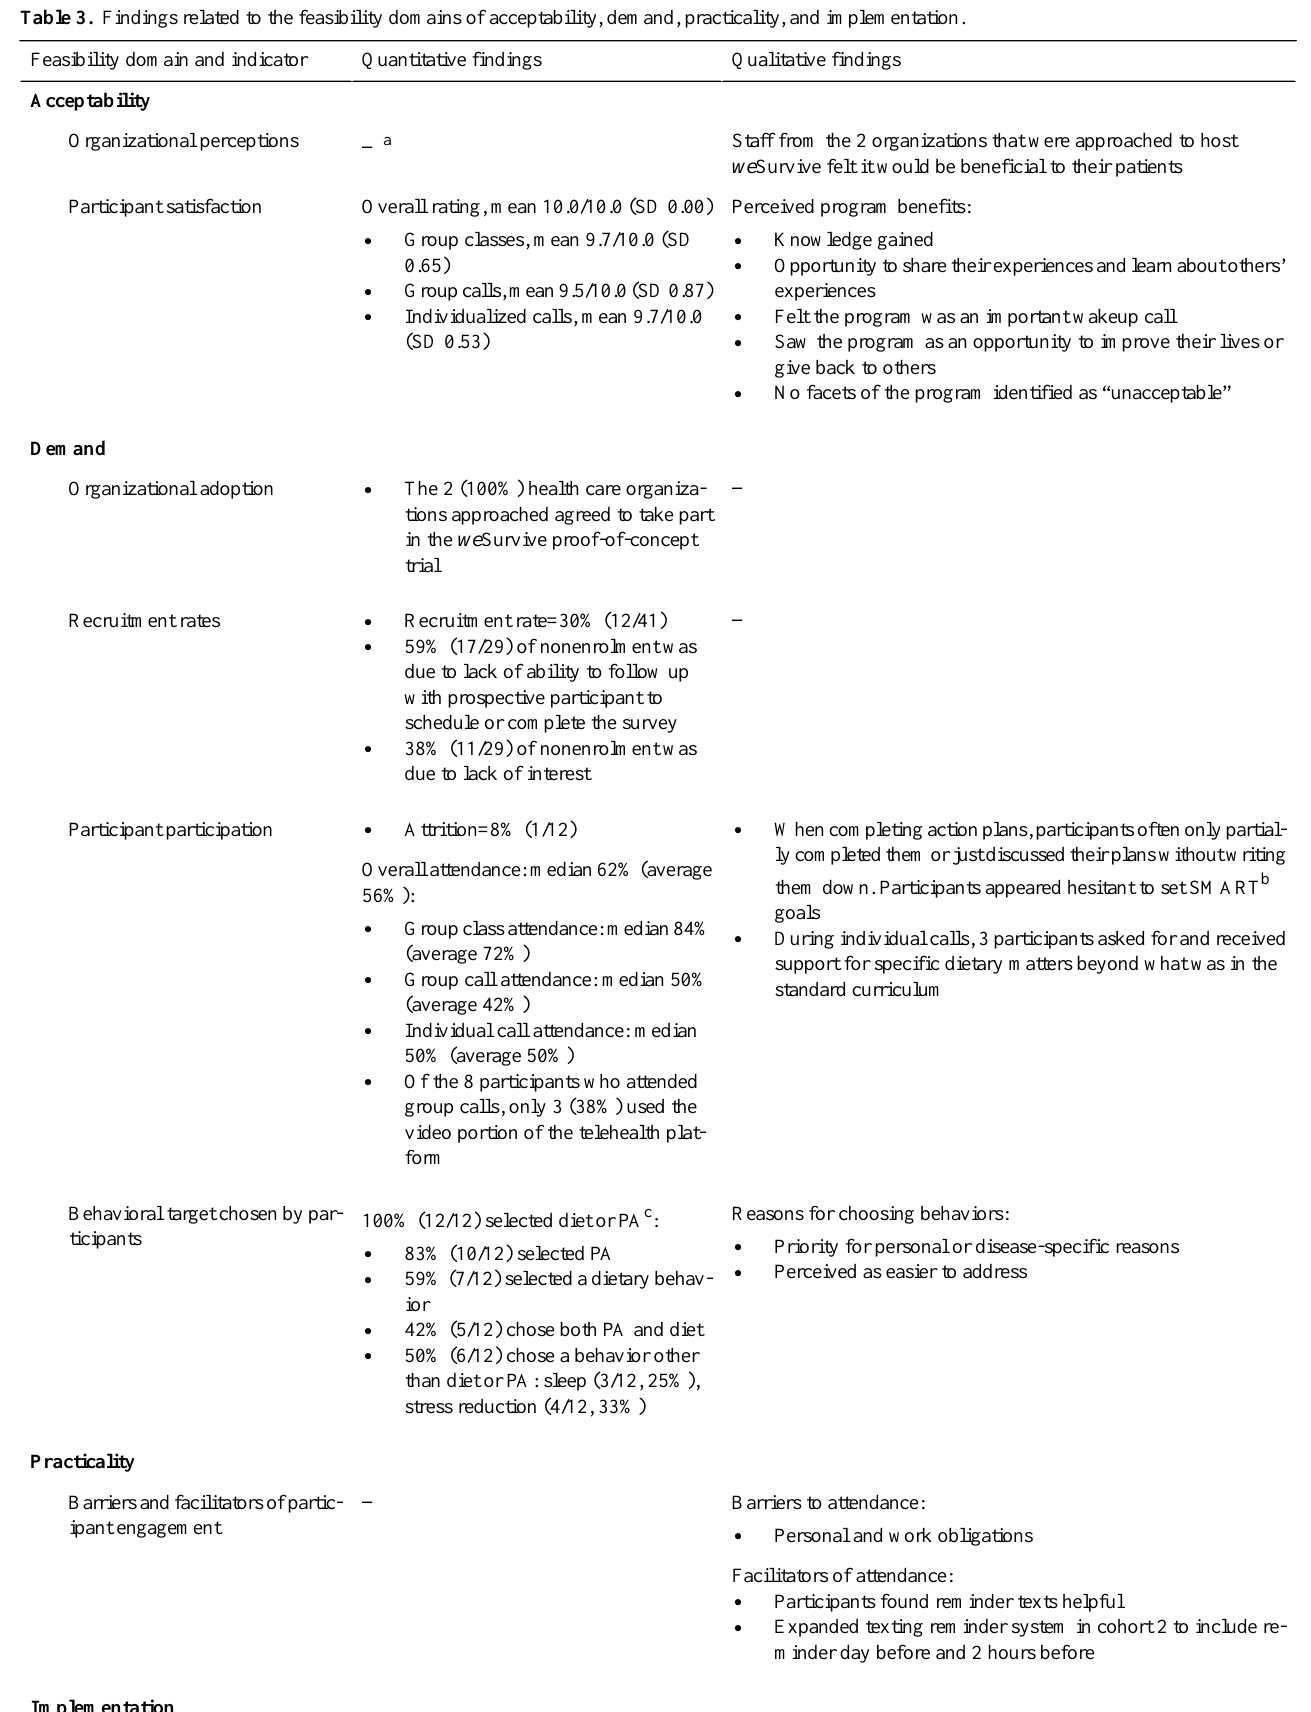
Table 3. Findings related to the feasibility domains of acceptability, demand, practicality, and implementation.